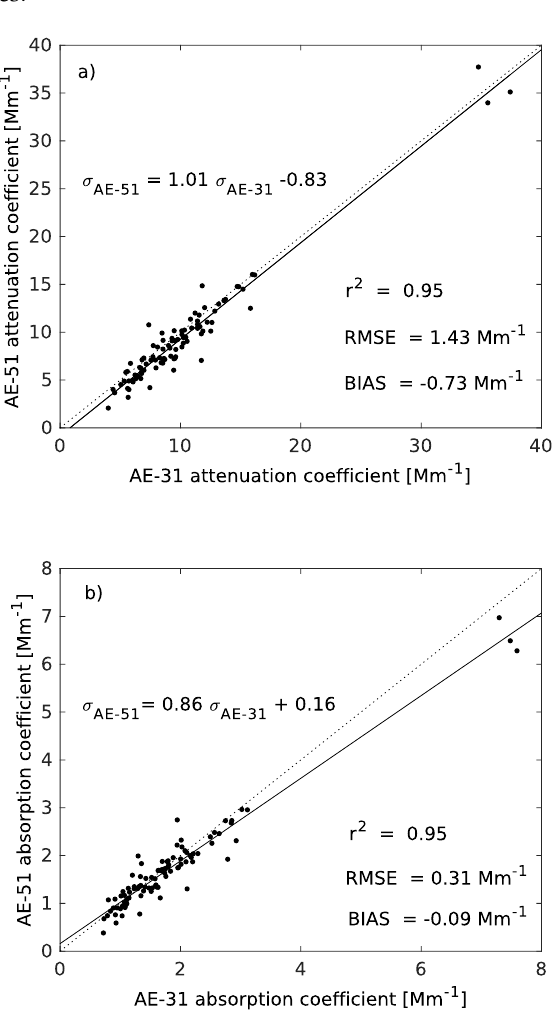
Figure 4. Comparison of ( a ) the attenuation and ( b ) absorption coefficients obtained from AE-31 and AE-51 during field campaign at SolarAOT in 2015. Solid line indicates linear fit and dotted line shows perfect